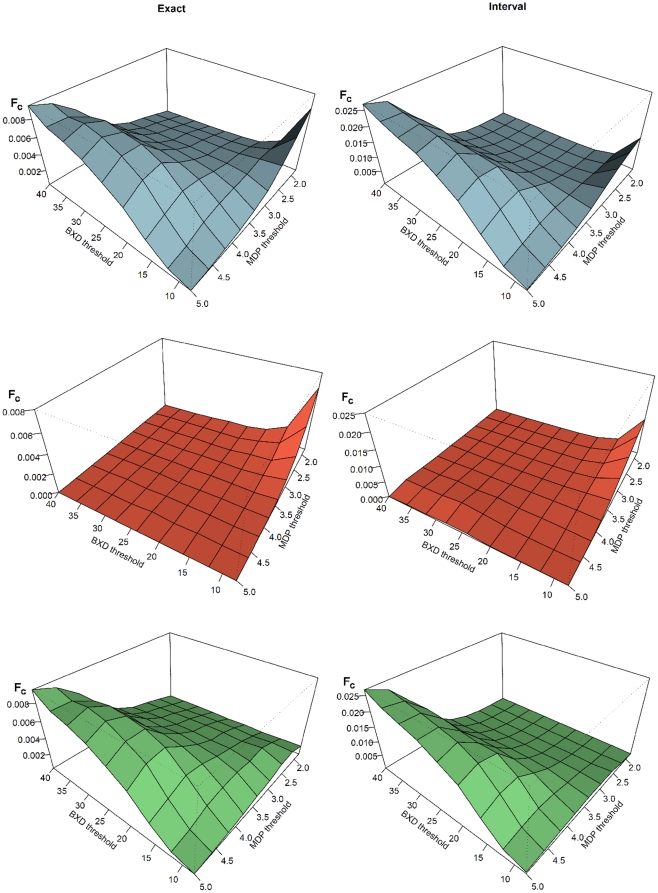
Consistency between MDP and BXD eQTL datasets.Average fraction of common eQTL signals, FC = mean(NHITS/(NMDP+NBXD)), as a function of BXD and MDP signal detection thresholds. The exact comparison (left) compares signals at identical markers in the two populations, whereas the interval comparison (right) summarizes the MDP values in proximity of BXD markers. Top panels: actual measurements. Middle panels: shuffled comparisons (10 randomizations). Bottom panels: difference between real and shuffled data for exact and interval comparison.